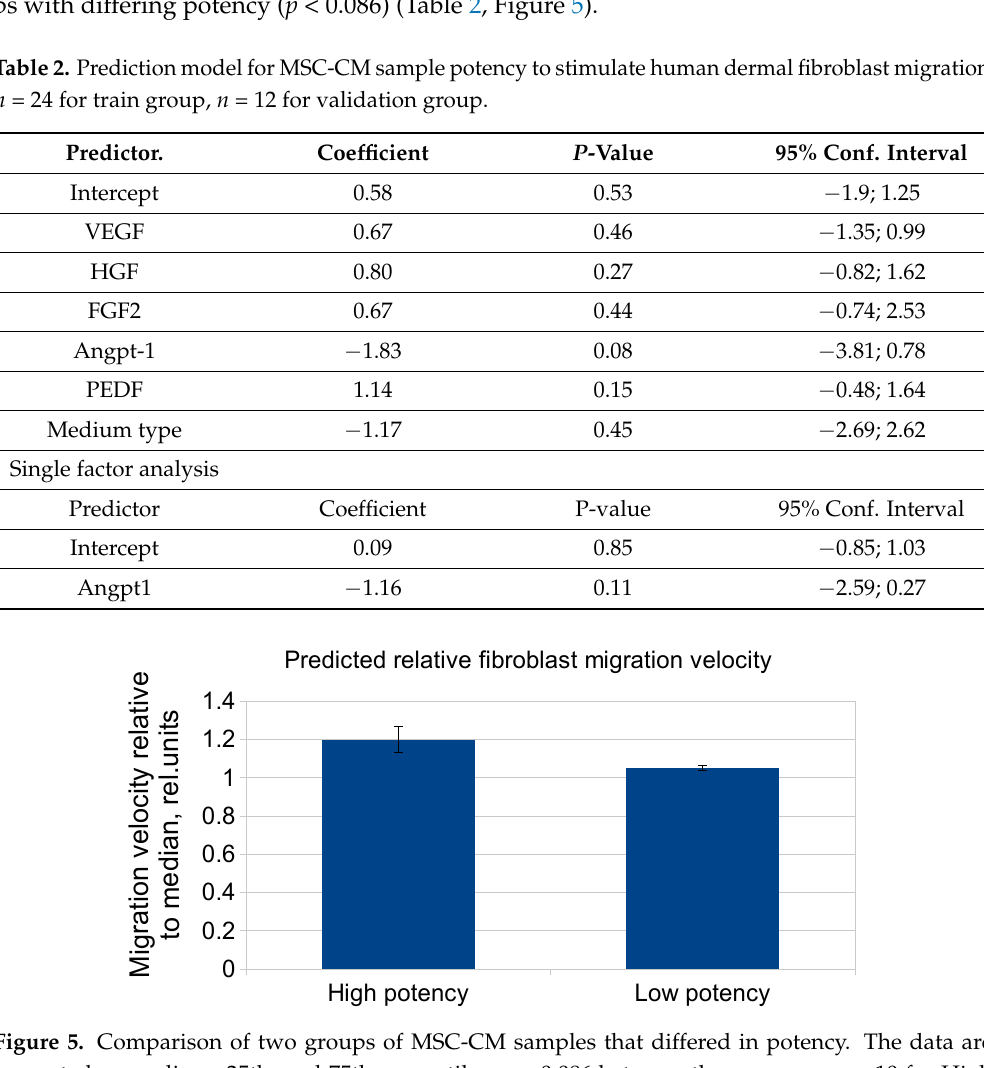
Table 2. Prediction model for MSC-CM sample potency to stimulate human dermal fibroblast migration; n = 24 for train group, n = 12 for validation group. Predictor.